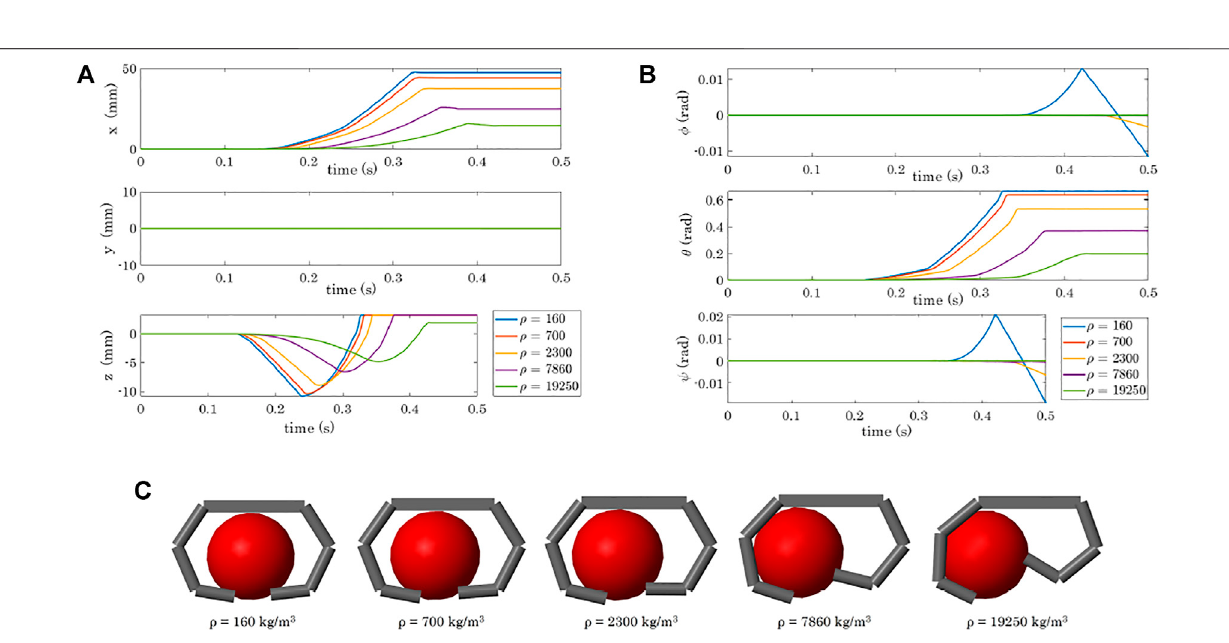
Frontiers in Robotics and AI |